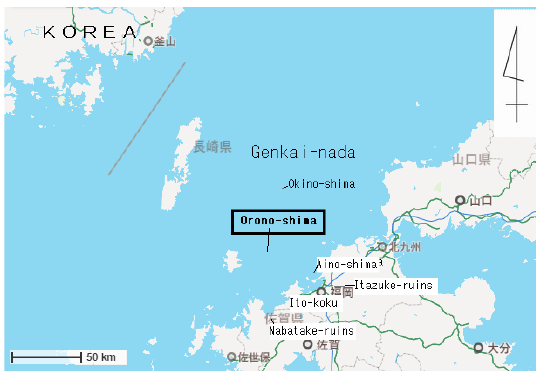
Fig.1 Genkai-nada sea area and Orono-shima Island （ picture from yahoo map modified by T.Yamaguchi